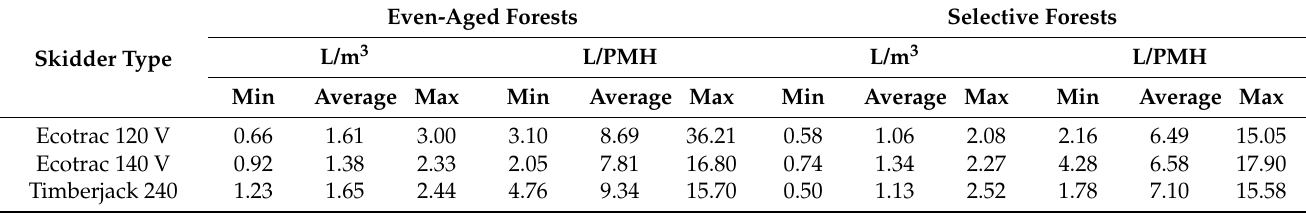
Table 2. Descriptive statistics of skidders fuel consumption in selective and even-aged forest